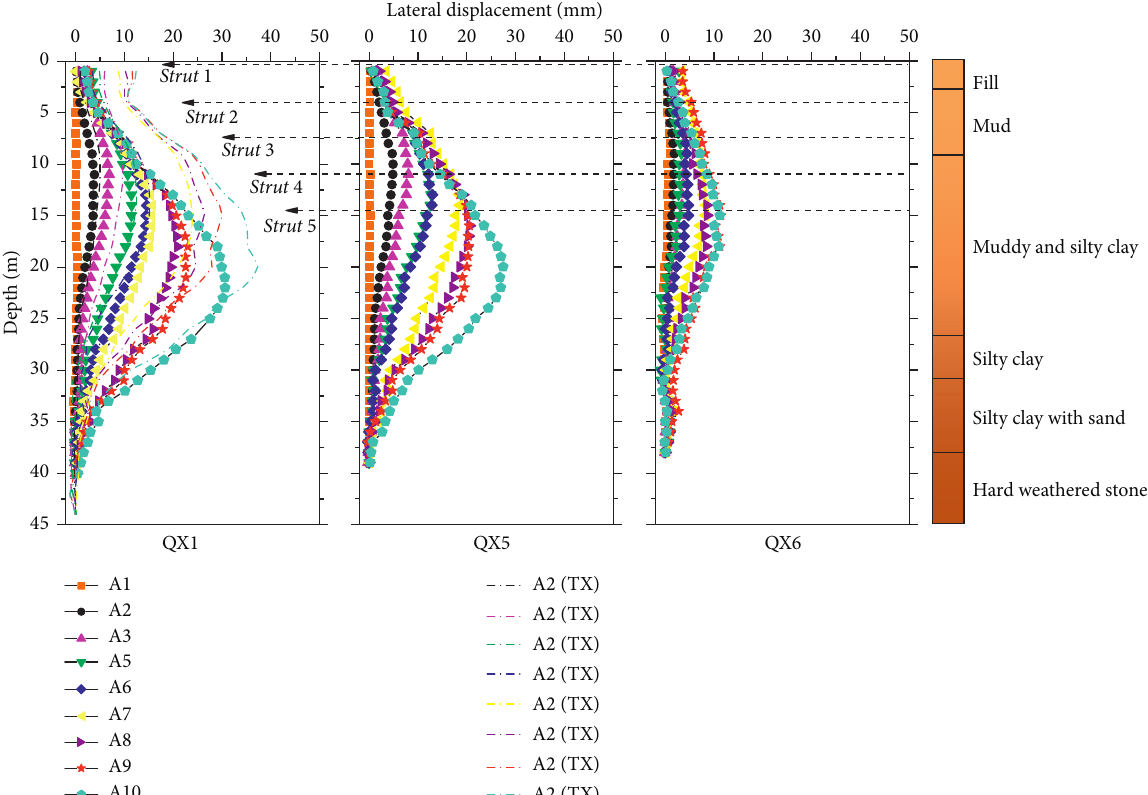
Figure 10: Lateral displacement of the diaphragm wall in